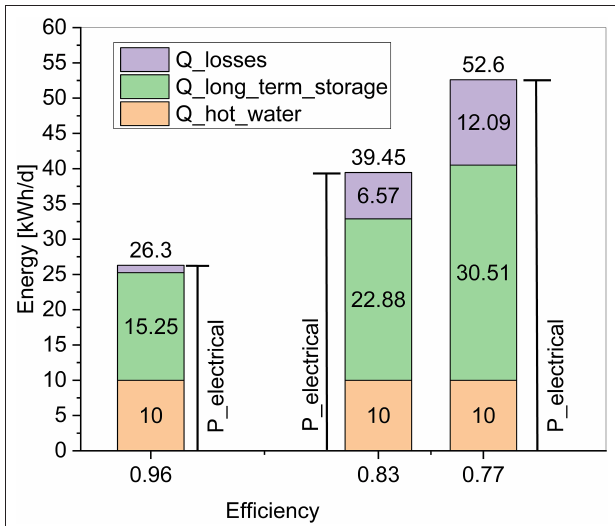
FIGURE 5 | Daily energy amounts for losses, hot water production, and long term storage charging for different amounts of total used electrical charging